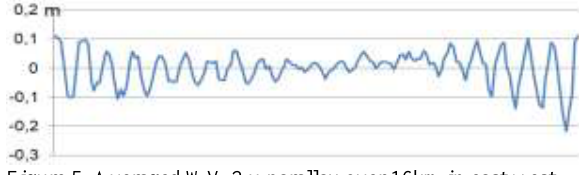
Figure 5. Averaged WV-2 y-parallax over 16km in east-west Figures 4 and 5 are demonstration the satellite jitter.